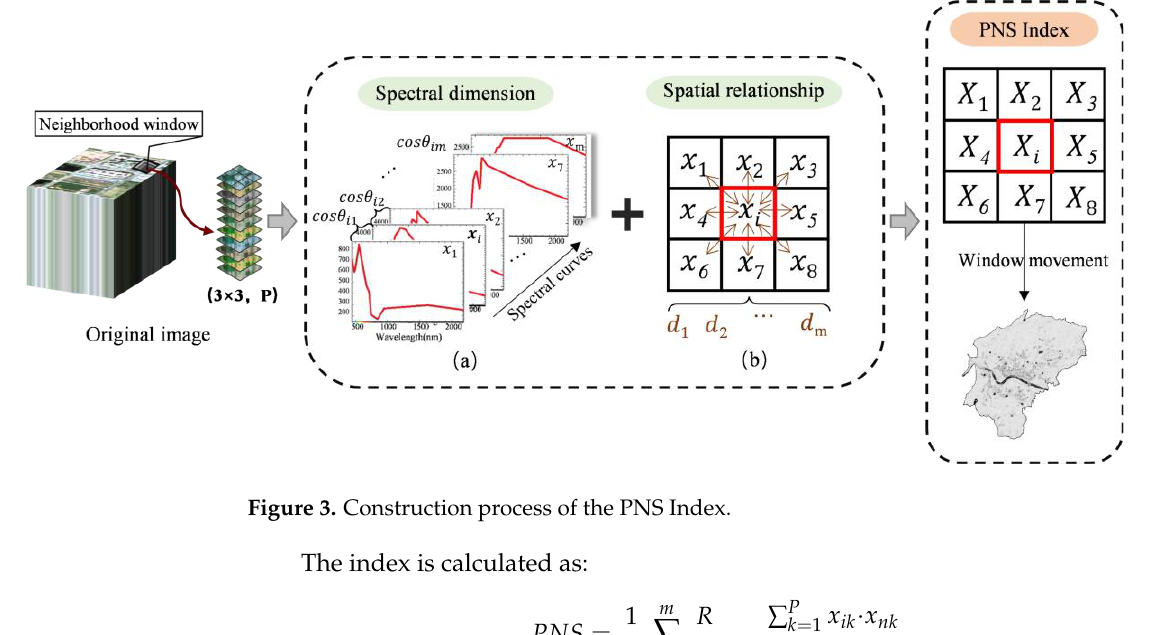
Figure 3. Construction process of the PNS Index.